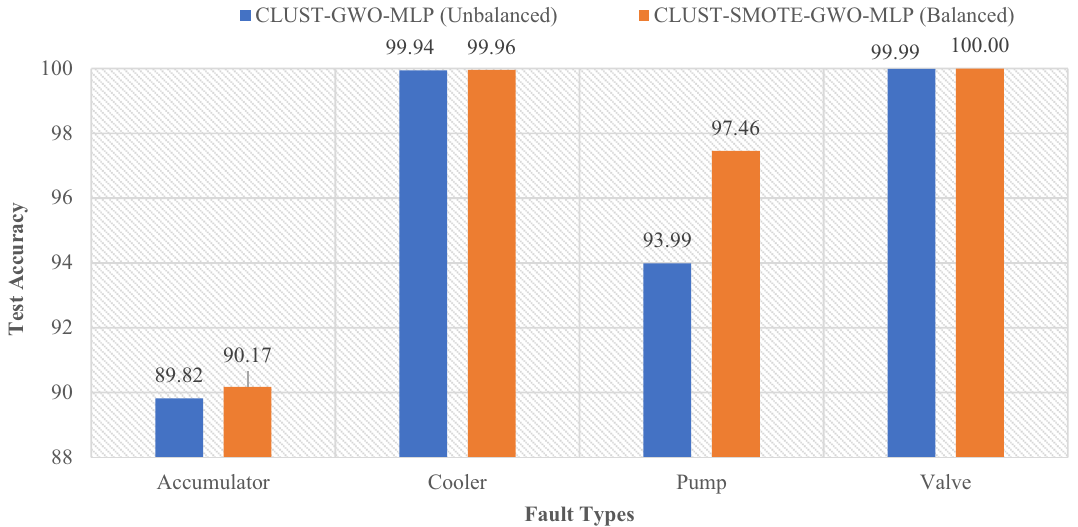
Fig. 4 Overall test accuracy of CLUST-GWO-MLP and CLUST-SMOTE-GWO-MLP in fault classification